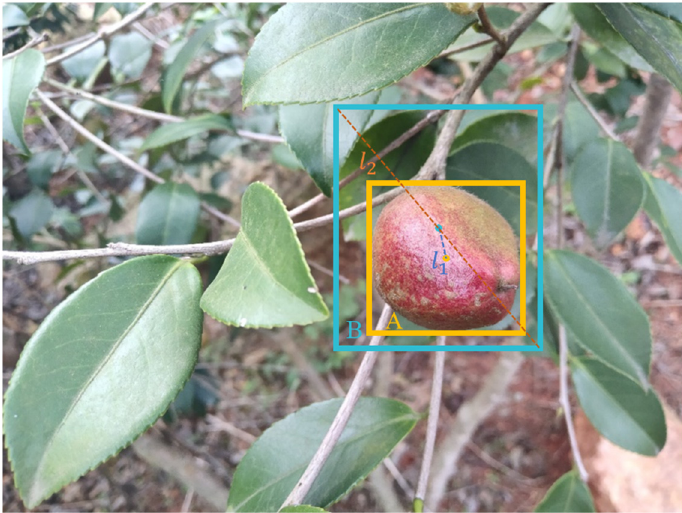
Figure 7. Visualisation of CIoU calculation between model prediction box and the ground truth. Yellow box is the calibration box, blue box is the prediction box.